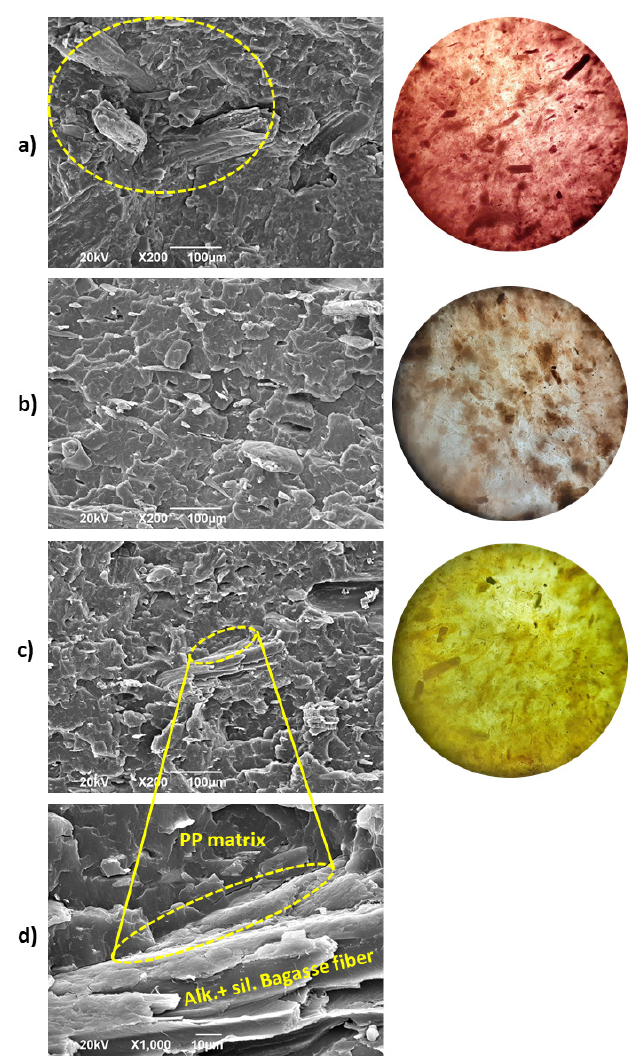
Figure 17. SEM ( left ) and optical micrographs ( right ) for 5th processing cycle: ( a ) PP.Bag., ( b ) PP-Bag + Alk. and PP-Bag + Alk. +sil. ( c and d ).